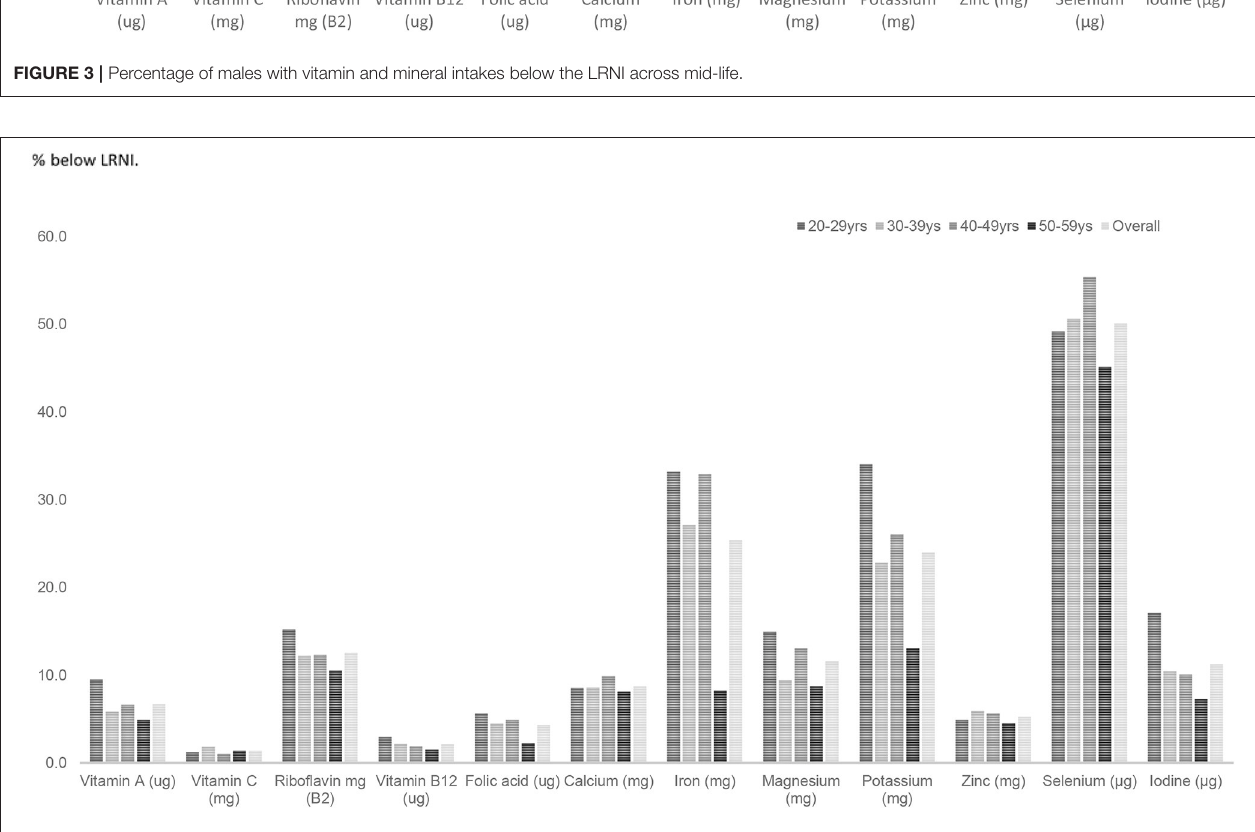
FIGURE 4 | Percentage of females with vitamin and mineral intakes below the LRNI across mid-life.